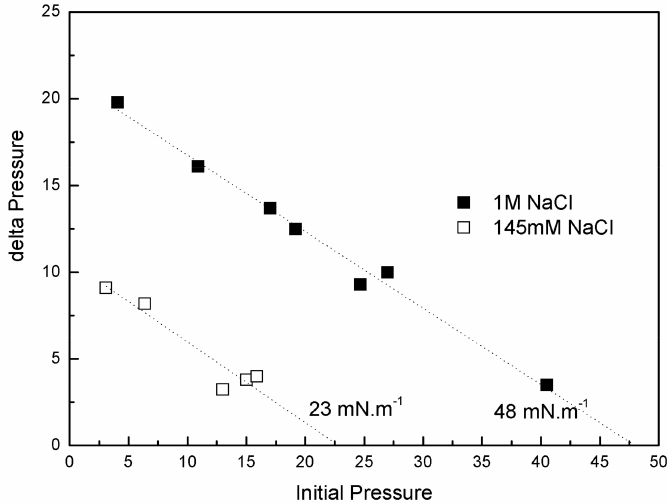
Figure 8. Penetration of IBU-Na into bacterial phospholipid monolayers. ( ∆ π ) max of IBU-Na versus initial surface pressure of phospholipid monolayers with 145 mM (empty squares) and 1 M (full squares) NaCl.